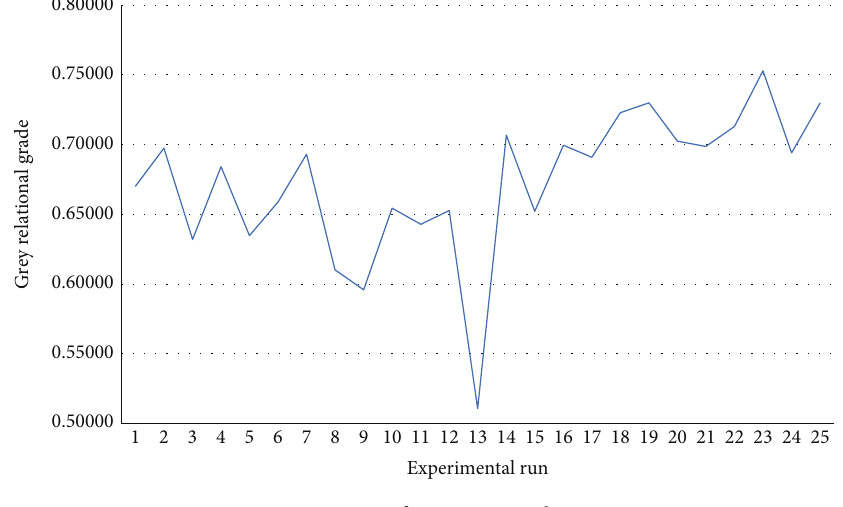
Figure 5: GRG for experimental run.